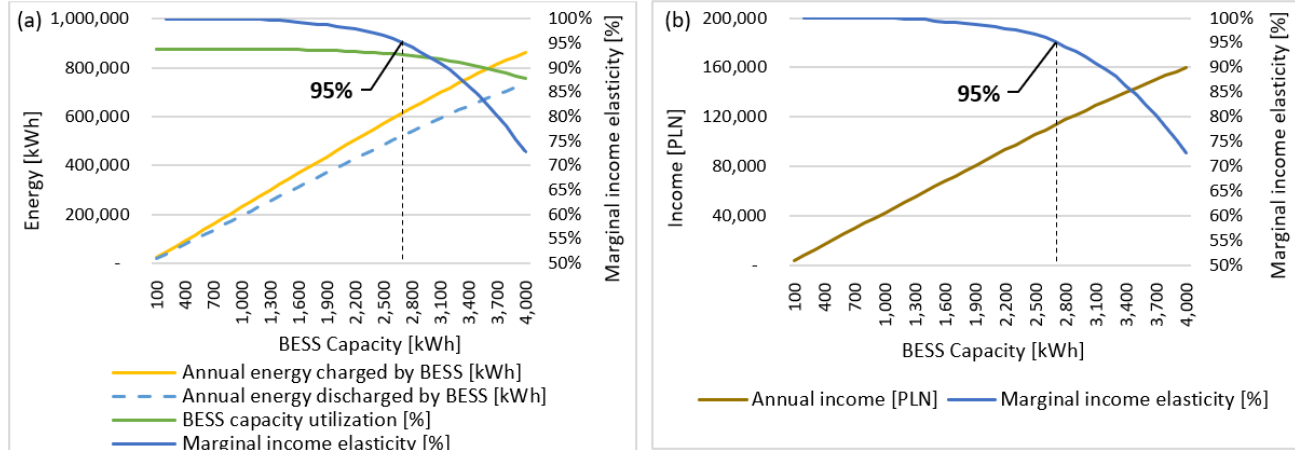
Figure 4. Results of the simulations of the price arbitrage strategy for the A2019 enterprise: ( a ) comparison of the marginal income elasticity parameter with the parameters of annual energy charged, annual energy discharged in kWh, and BESS capacity utilization in %; ( b ) comparison of the marginal income elasticity parameter and the annual income in